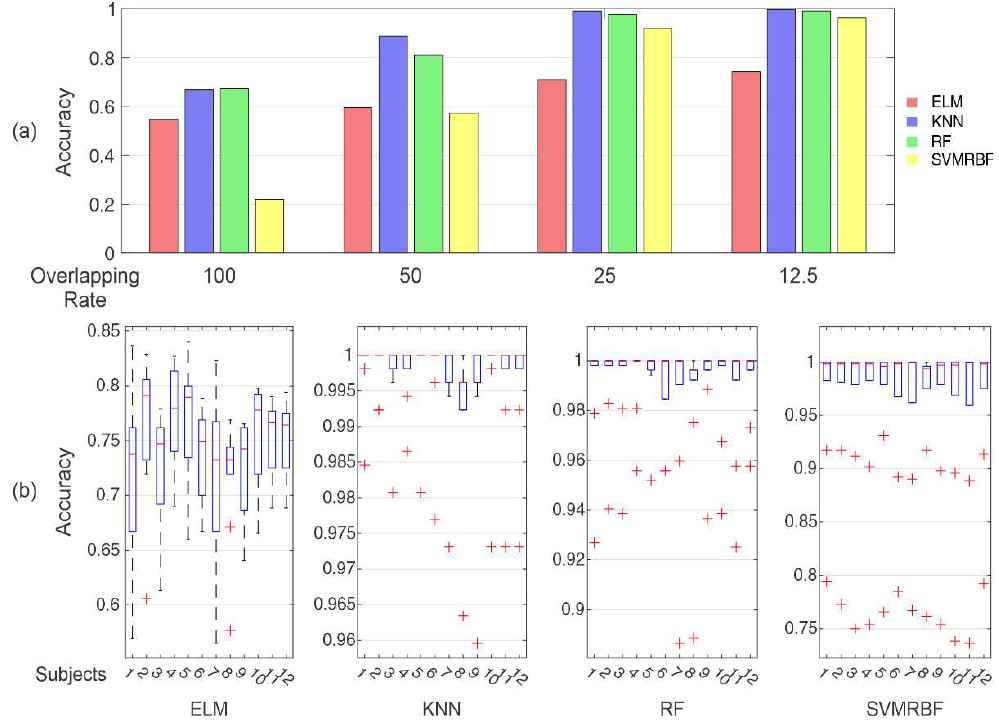
Figure 11. Hit rates obtained for acquisition trial validation. ( a ) Accuracies obtained for all subjects considering the variation of signal overlap related to classifiers. ( b ) Distribution of accuracies for an overlap rate of 12.5% (the best value observed in (a) for each subject and classifier). The bars represent the 25 th and 75 th percentiles; the whiskers represent approximately 99.3% of the coverage of distribution, and the crosses (+) are the outliers.